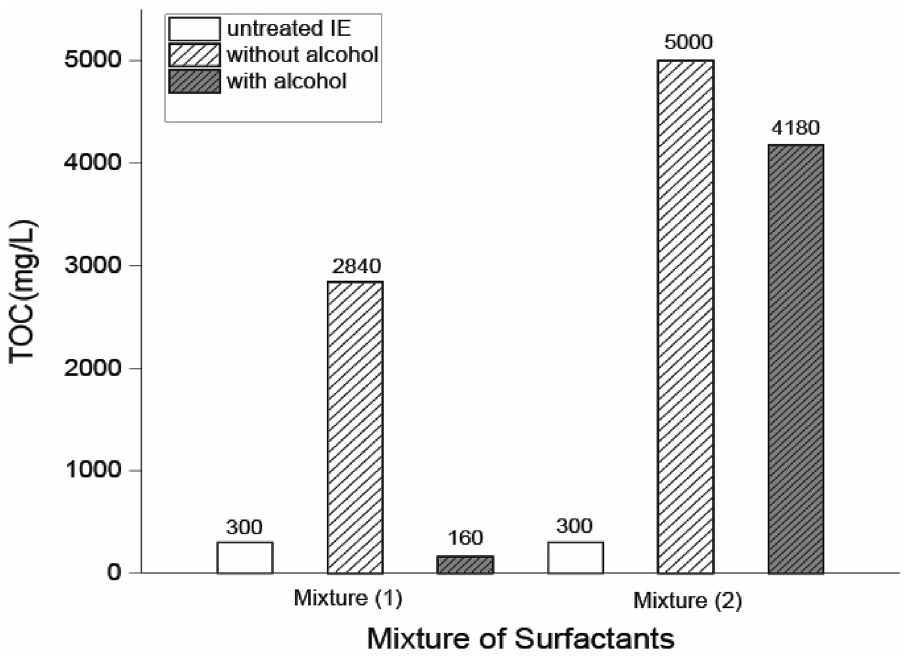
Figure 5. The comparison between TOC results of industrial wastewater system ( IE) containing Mixture (1) and Mixture (2) before and after injecting sec-butanol. TOC measurement uncertainty is about 50 mg/L based on the TOC analyzer